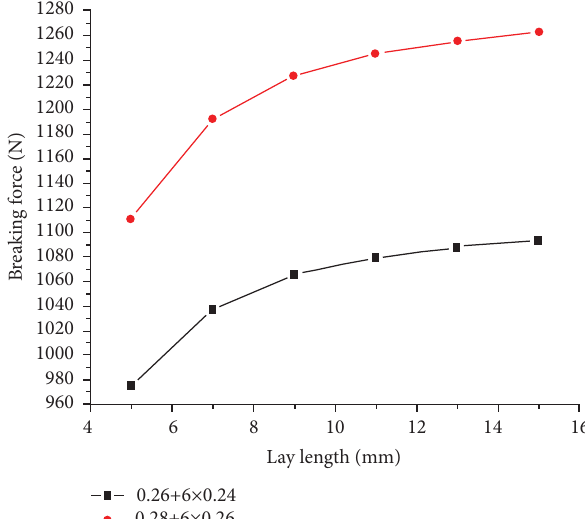
Figure 7: 0.26+6 × 0.24 steel cord and 0.28+6 × 0.26 steel cord elongation at break change curve with lay